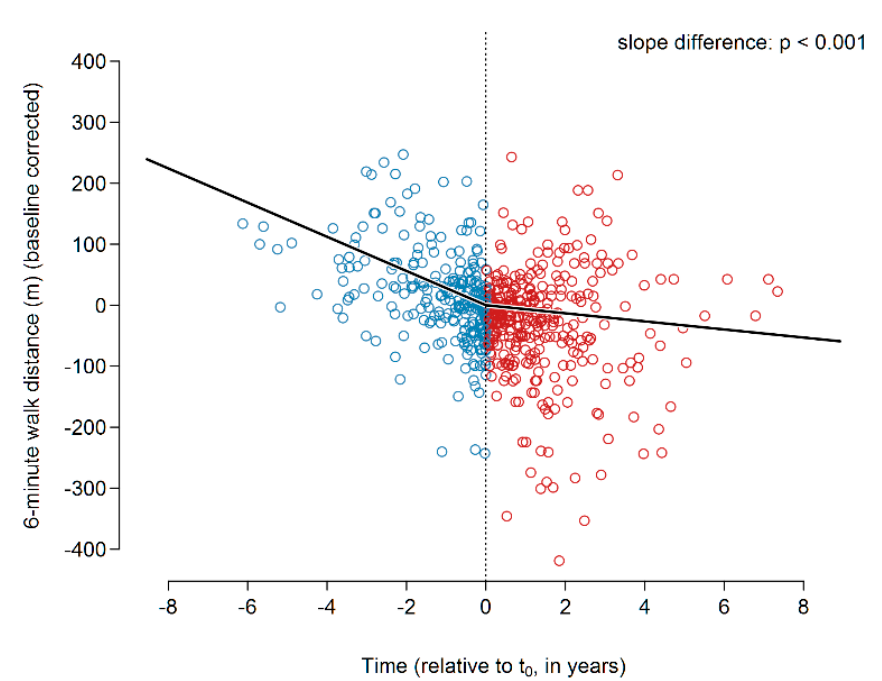
Figure 3. Borg dyspnea scale before and during pirfenidone treatment. Figure 3 . Borg dyspnea scale before and during pirfenidone treatment.